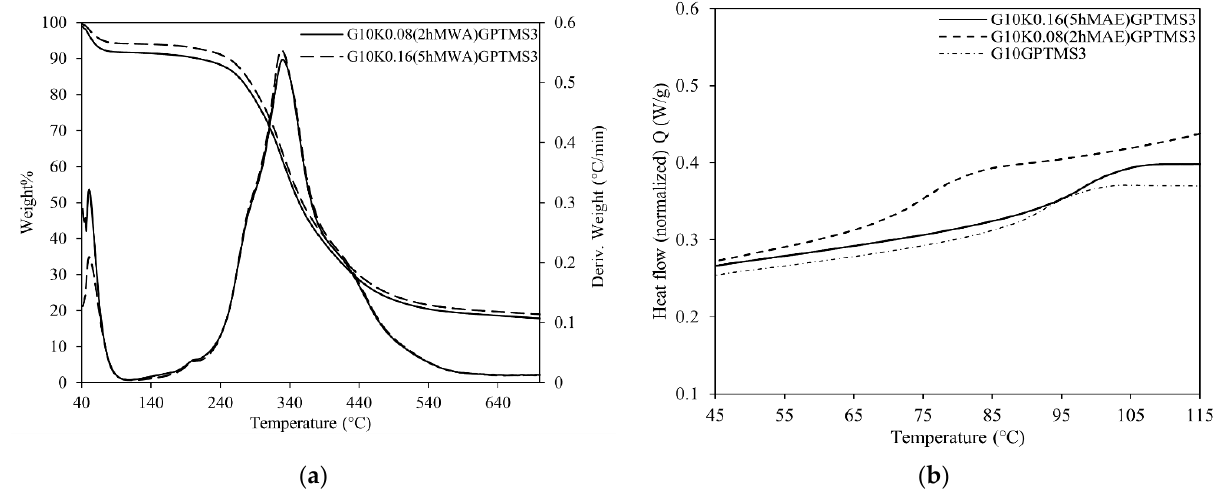
Figure 3. ( a ) Thermogravimetric curve (left axis) and its DTG (right axis) under nitrogen flow at a 10 °C∙min −1 heating rate of G 10 K 0.08 (2hMAE)GPTMS 3 and G 10 K 0.08 (2hMAE)GPTMS 6 ; ( b ) Experimental DSC curves of the heat flow normalized in the second heating vs. temperature (heating rate 10 °C∙min − 1 ) for G 10 GPTMS 3 (dash-dotted line), G 10 K 0.08 (2hMAE)GPTMS 3 (dashed line), G 10 K 0.16 (5hMAE)GPTMS 3 (solid line).